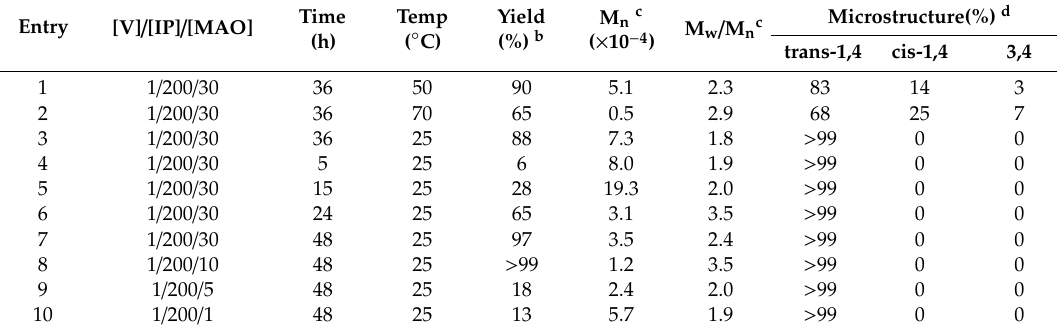
Table 1. E ff ects of temperature and time of VCl 3 / methylaluminoxane (MAO) catalyst a .